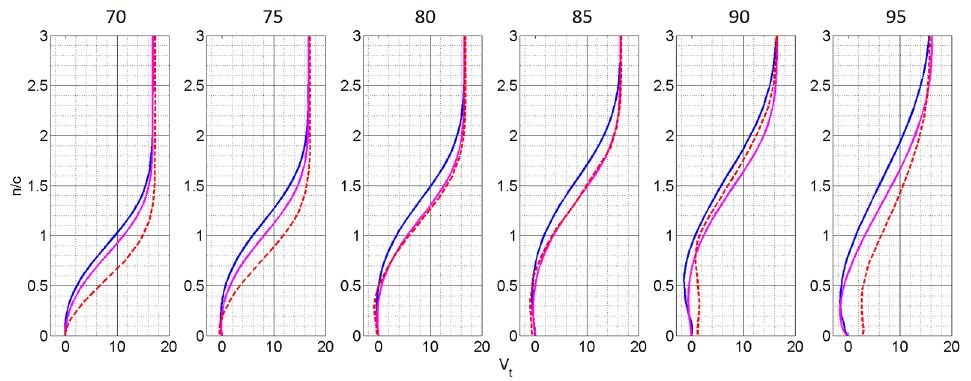
Figure 14. Time-averaged U-velocity contours in 2D ( a ) and 3D ILES ( b ). Baseline case for NACA- Figure 15. Comparison of 2D (blue) and 3D ILES (magenta) vs. measured (red) suction-side Figure 15. Comparison of 2D (blue) and 3D ILES (magenta) vs. measured (red) suction-side boundary layer profiles. 0012 at 0° AoA and U = 16 m/s. [18]. boundary layer profiles. Time-averaged U–velocity, NACA-0012 at 0° AoA and U = 16 m/s. [18]. Time-averaged U–velocity, NACA-0012 at 0 ◦ AoA and U = 16 m/s